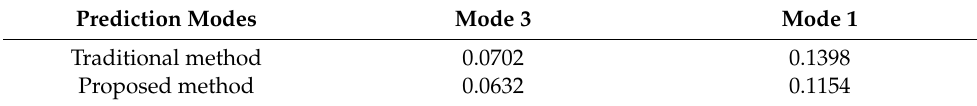
Figure 4. Single-mode online prediction of mode 3. Table 3. RMSE of the different prediction modes in single-mode